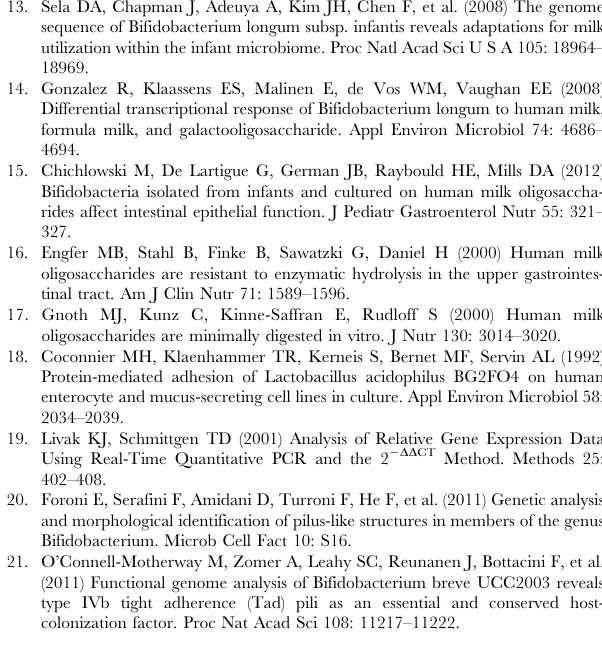
mixture. Figure S3 Transcription levels (fold-change) for the cluster of genes for LNB/GNB metabolism. 3 9 sialyllactose (white shading); 6 9 sialyllactose (black and white diagonal shading); 3 9 - and 6 9 -sialyllactose mixture (black shading).